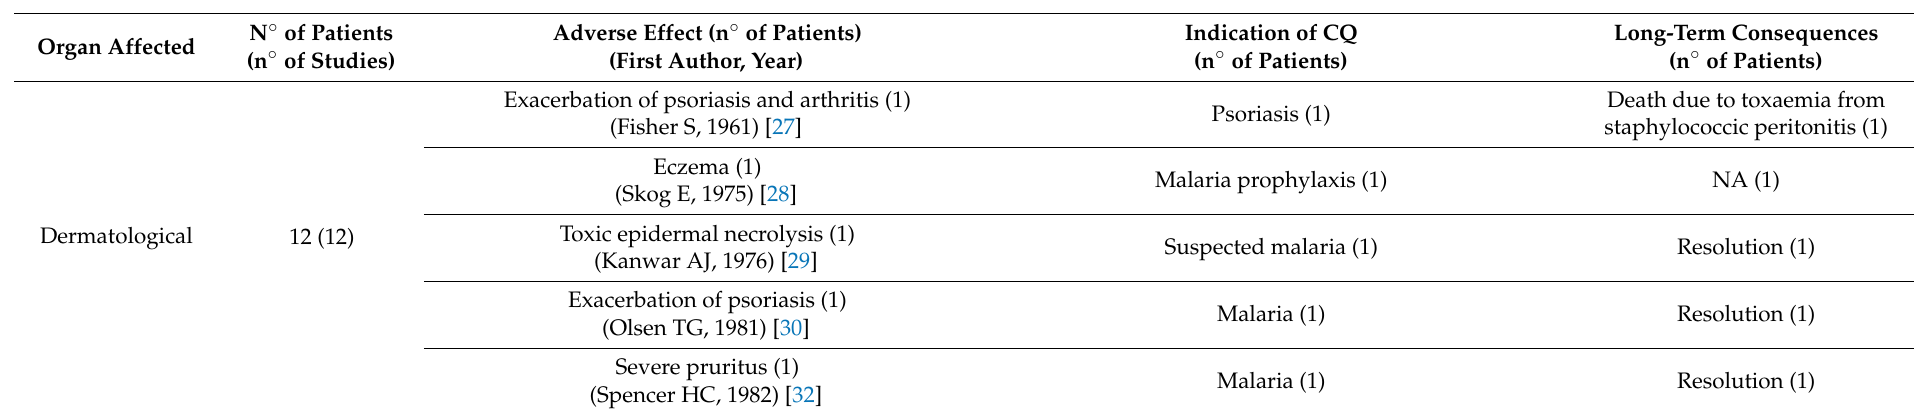
Table 2. Summary of studies included: case reports and case series reports related to CQ adverse